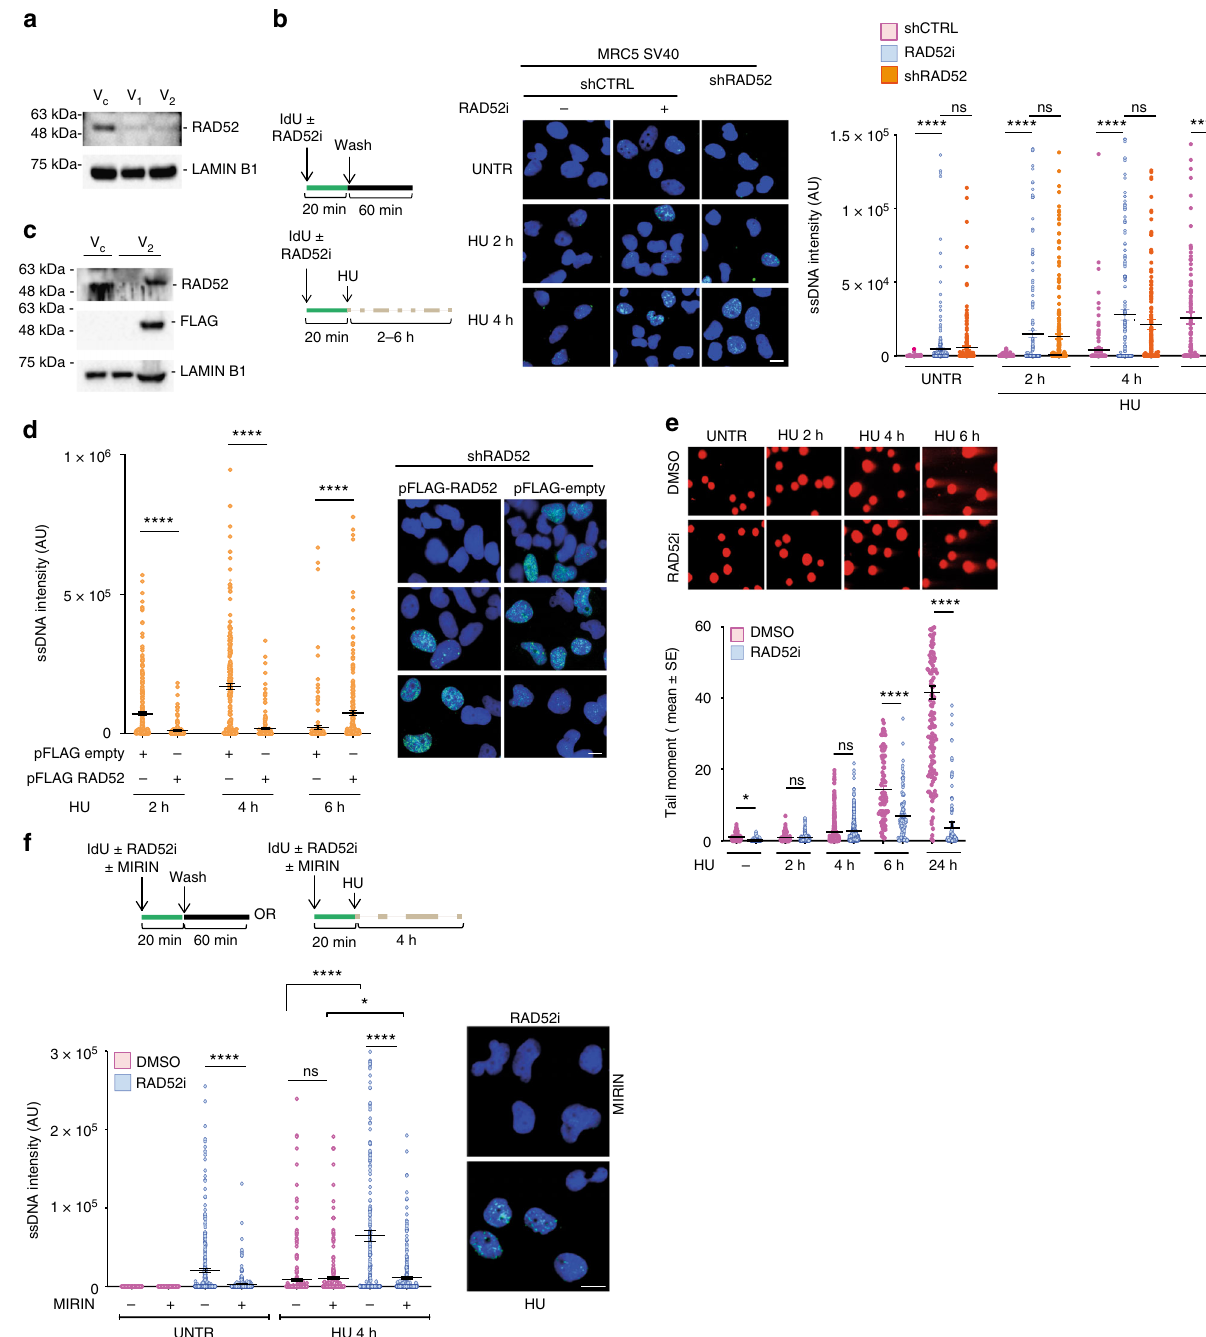
Fig. 1 Loss of RAD52 causes MRE11-dependent accumulation of nascent ssDNA. a Western blot shows level of RAD52 protein in cells were infected with two different viruses (V 1 or V 2 ) containing short hairpin RNA (shRNA) sequences against RAD52. LAMIN B1 was used as loading control. C = control virus. b Analysis of nascent ssDNA after 2 mM hydroxyurea (HU) treatment. On top: schematic of the experiment. Graph shows the intensity of ssDNA staining for single nuclei. Values are presented as means ± SE (ns = not signi fi cant; **** P < 0.0001; Mann – Whitney test; N = 184). Representative images are shown. c Western blot analysis of FLAG-RAD52 transfection. LAMIN B1 was used as a loading control. d Cells were transfected with FLAG-RAD52 or FLAG-empty 48 h before to perform nascent ssDNA immunostaining. Dot plots show the mean intensity of ssDNA staining for single nuclei from each cell line after treatment with HU 2 mM. Values are presented as means ± SE (**** P < 0.0001; Mann – Whitney test; N = 184). Representative images are shown. e Cells were treated with 2 mM HU at different time points and collected to perform neutral comet assay. Data are presented as mean tail moment ± SE from two independent experiments. N = 93 (ns = not signi fi cant; * P < 0.1; **** P < 0.0001; Mann – Whitney test). Representative images are shown. f Cells were treated as indicated in the schemes. Graph shows the mean intensity of ssDNA staining for single nuclei from each cell line. The intensity of the anti- iododeoxyuridine (IdU) immuno fl uorescence was measured in at least 100 nuclei from two independent experiments. Values are presented as means ± SE (ns = not signi fi cant; * P < 0.1; **** P < 0.0001; Mann – Whitney test; N = 290). Representative images of ssDNA formation are given. Scale bar represents 5 µ m. Source data are provided as a Source Data fi